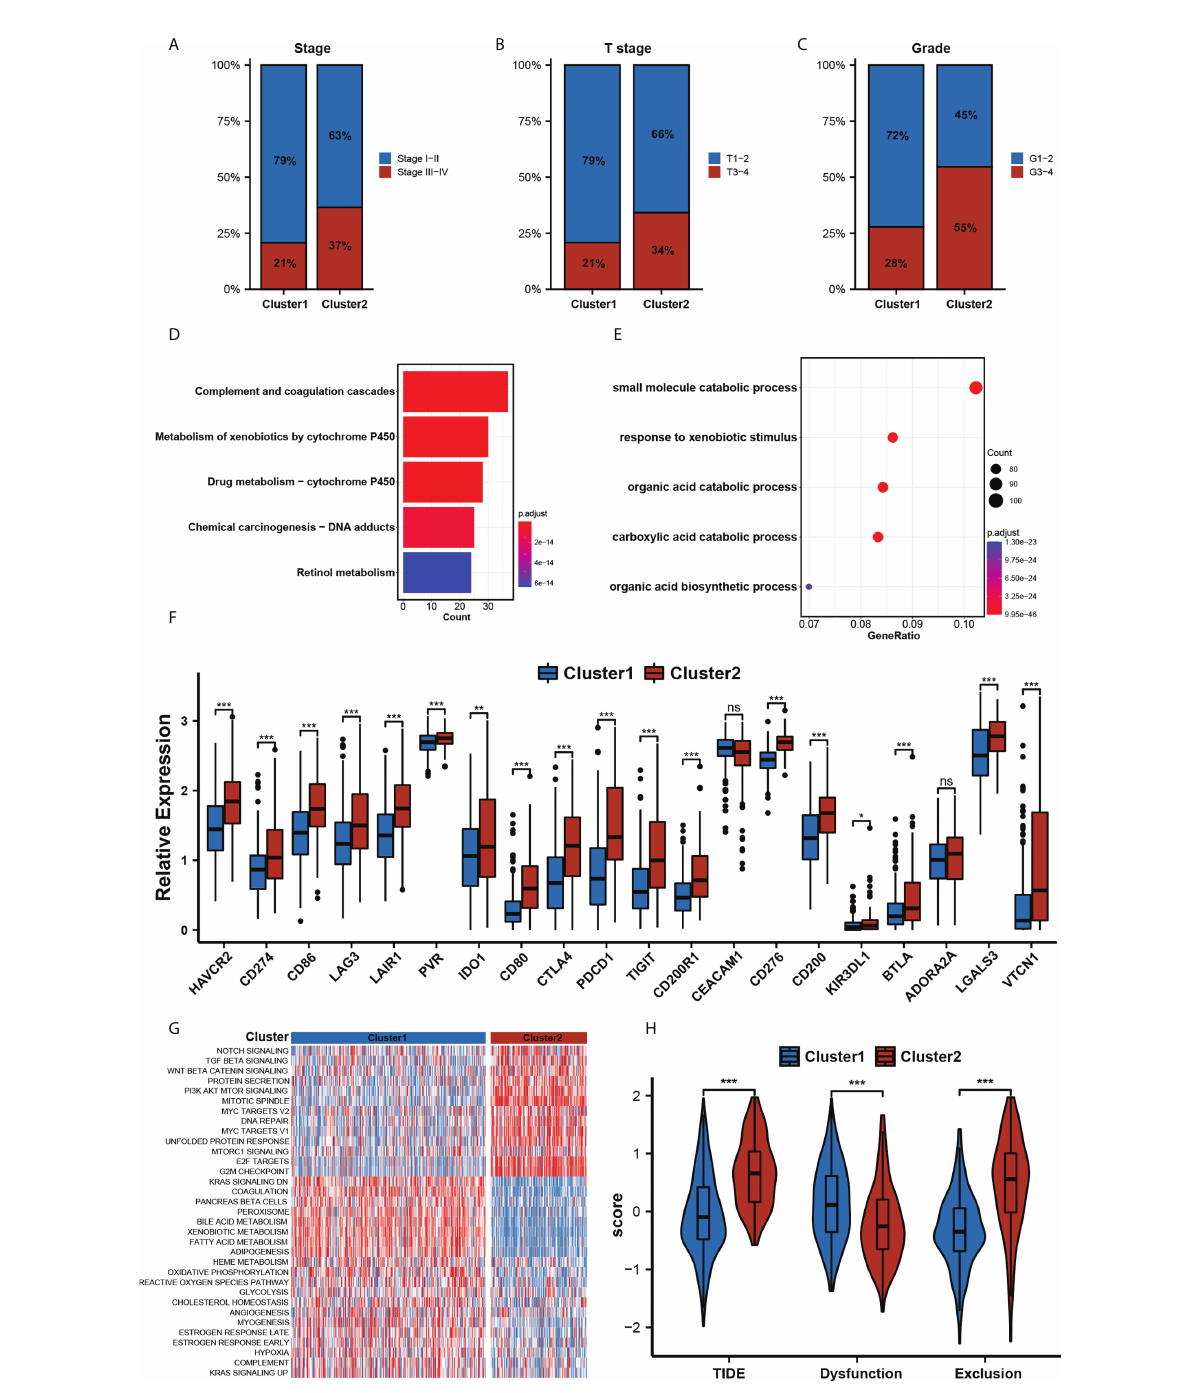
FIGURE 3 Clinical Characteristics Gene Sets Enrichment between clusters. (A-C) The clinical characteristics included Neoplasm Disease Stage. (A) , Cancer Tumor Stage (B) , and Neoplasm Histologic Grade (C) between two m 5 C clusters(Chi-square test, p< 0.01). (D, E) The top 10 signi fi cant GO analysis terms (D) and KEGG pathways (E) of DEGs in two clusters. (F) . The relative expression levels of 20 immune checkpoints in two m 5 C clusters. (* p<0.05, ** p<0.01, *** p<0.001, ns: no signi fi cant difference). (G) . HALLMARK pathway enrichment analysis of two m 5 C clusters by GSVA. (H) . The relative distribution of TIDE was compared between two m 5 C